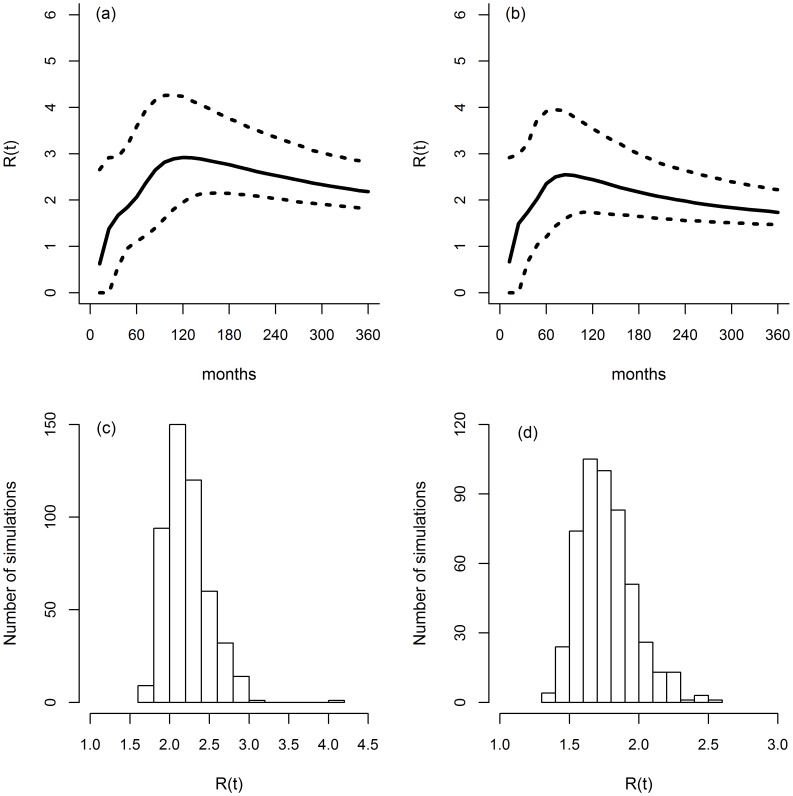
Monthly evolution of the simulated effective reproductive ratio R(t) (a and b), and distribution of this R(t) (c and d) when the disease has become enzootic (after 30 years) in standard French beef (a and c, 70 animals) and dairy (b and d, 81 animals) herds.Solid line: median; dashed: 2.5% and 97.5% percentiles.